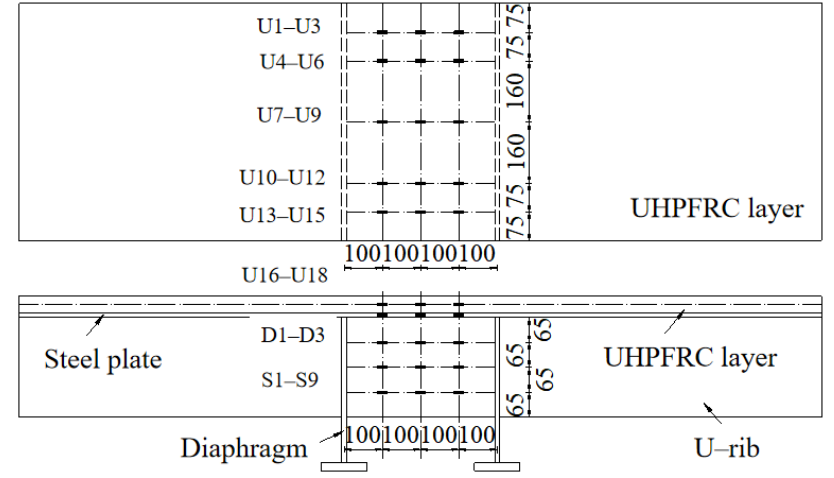
Figure 9. Layout of strain gauges (unit: mm).